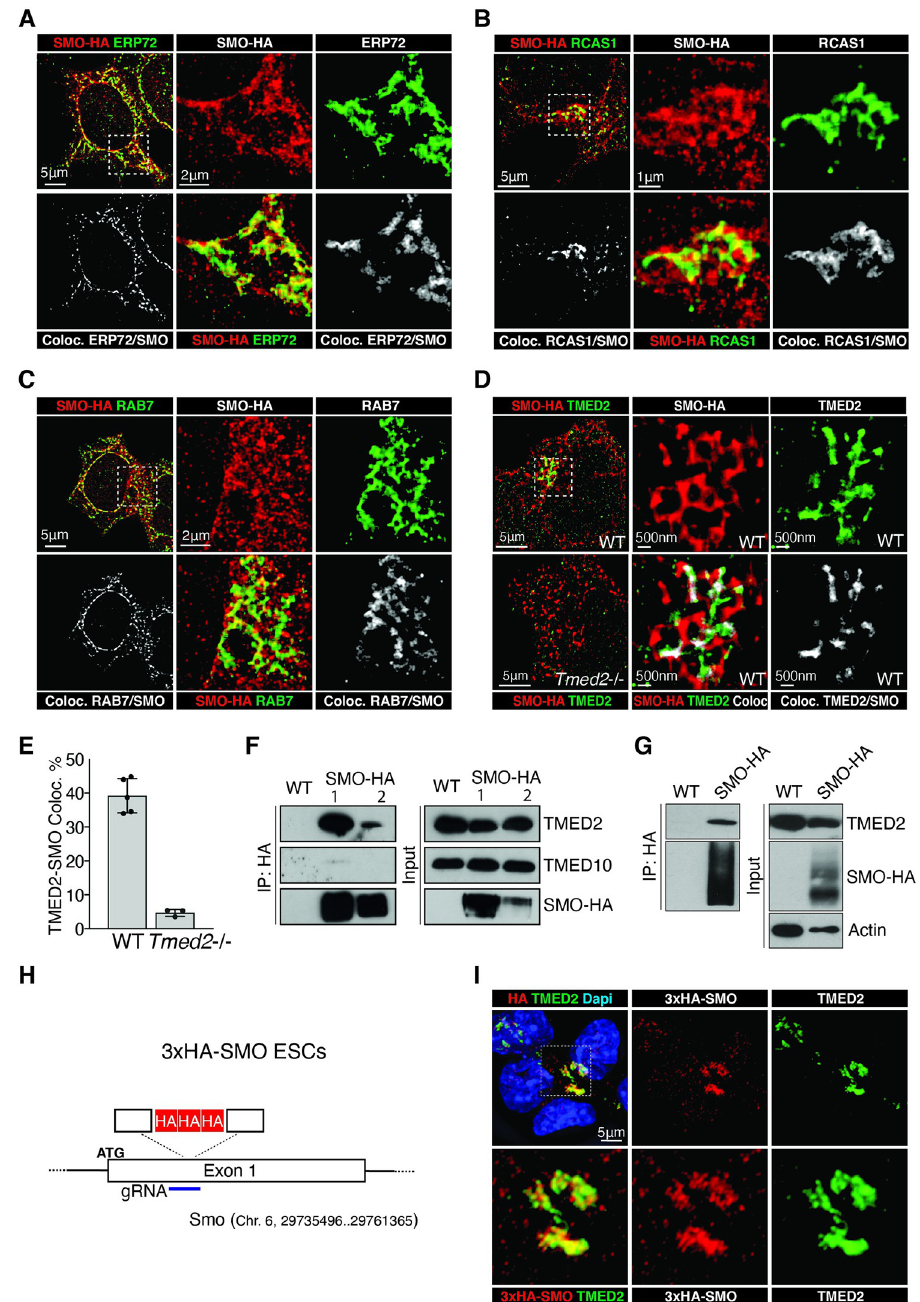
Fig 6. SMO interacts with TMED2 in the Golgi compartment. (A–C) Super-resolution SMO colocalization with (A) ERP72, (B) RCAS1, and (C) RAB7. SMO–HA cells were differentiated into NPCs and SMO–HA cellular distribution (red) was compared to organelle marker staining (green) in dual-color 3D-STORM experiments. Colocalizing events are shown in independent plots and labeled in gray; scale bar = 5 μ m. Magnified areas are shown on the left; scale bar = 2 μ m. (D) SMO colocalizes with TMED2 in NPCs in dual-color 3D-STORM experiments. Colocalization between SMO–HA (red) and TMED2 (green) is shown in the top left panel and compared to the one detected in parental cells with a Tmed2 mutation (bottom right); scale bar = 5 μ m. Magnified area is shown on the left; scale bar = 500 nm. Colocalizing events are labeled in gray. (E) Quantification of the colocalizing events in SMO–HA NPCs WT and depleted for Tmed2 . (F) TMED2 binds SMO in ESCs. Western analysis of coimmunopurification of endogenous TMED2 and TMED10 with SMO–HA (left) and input (1/25 of IP, right) from extracts of 2 independent ESCs clones expressing SMO–HA. (G) TMED2 binds SMO in NPCs. Western analysis of coimmunopurification